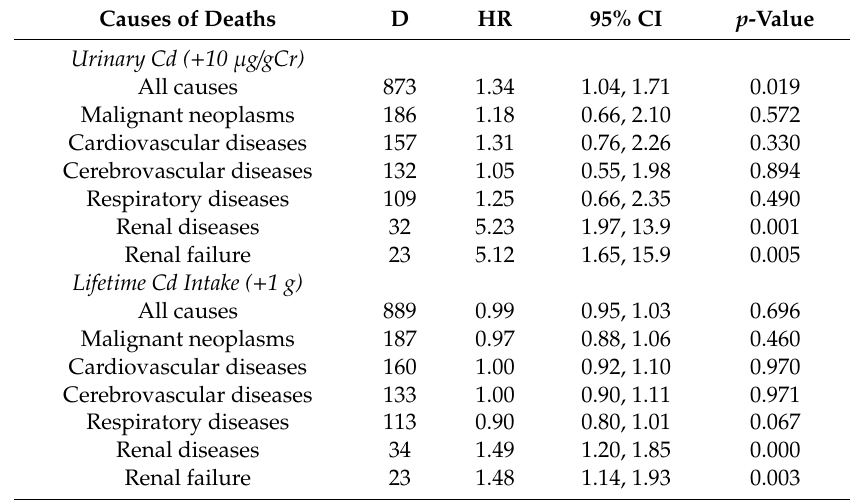
Table 3. Dose–response relationships between hazard ratios and Cd exposure markers in women. Causes of Deaths D HR 95% CI p -Value Urinary Cd ( + 10 µ g / gCr) All causes 873